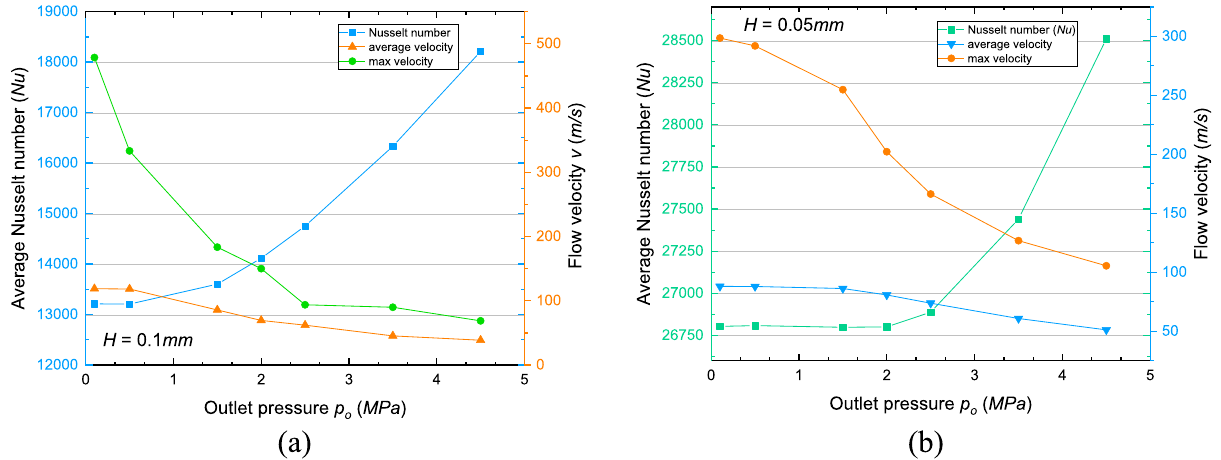
Fig. 17. Variation of average Nusselt number Nu and fl ow velocity v as functions of outlet pressure po, di=6 mm, q=0.06 kg/s. (a) H=0.1 mm. (b) H=0.05